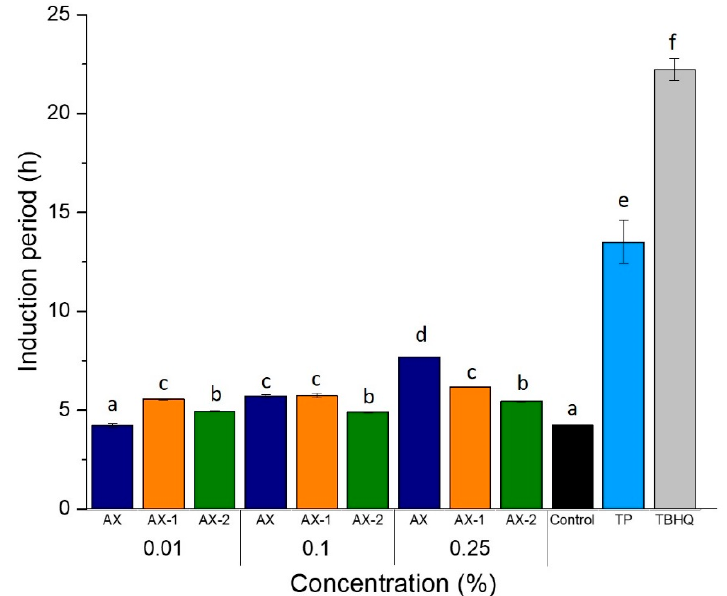
Figure 4. Oxidative stability of soybean oil treated with di ff erent concentrations of AX, AX-1, AX-2 (% w / v ), tocopherol (TP, 0.02% w / v ) and tertbutylhydroquinone (TBHQ, 0.02% w / v ) at 110 ◦ C and air-flow rate of 20 L / h. Antioxidant-free soybean oil was used as Control. Results are expressed as means ± SD of three replicates. Di ff erent letters within the same group of concentration indicate statistical di ff erence ( p < 0.05) when compared with Control. Table 3. Protection factor values of AX on oxidative stability of soybean oil.